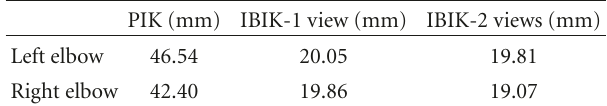
Table 1: Comparison by using the manually annotated sequence.